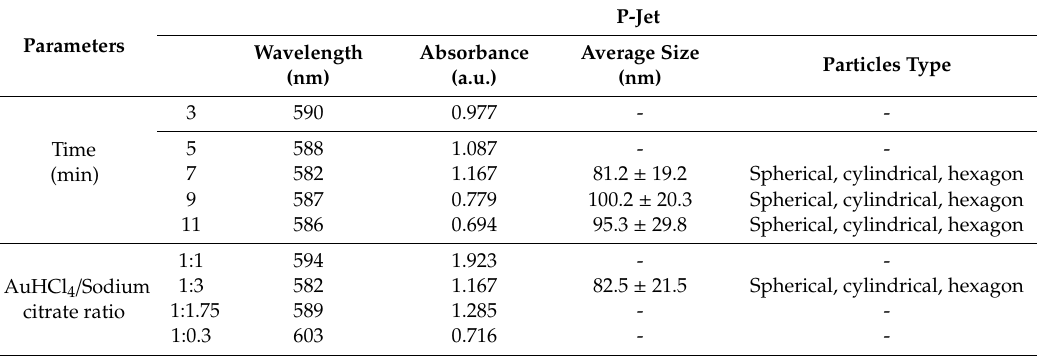
Table 2. Summarize of AuNP properties treated by